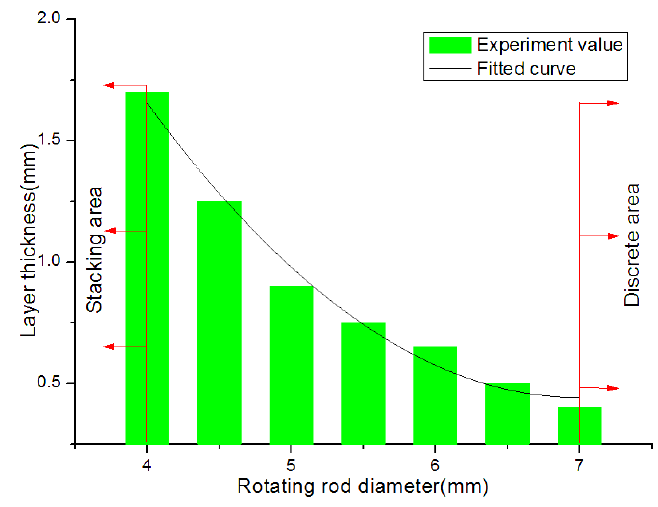
Figure 9. The relationship between film thickness and rotating rod diameter.